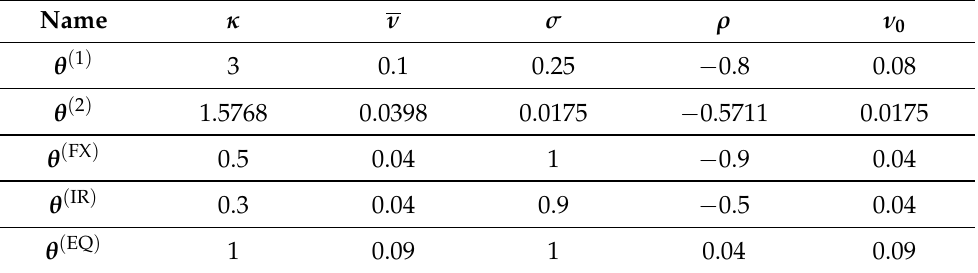
Table 1. Set of Heston parameters used in the numerical tests.